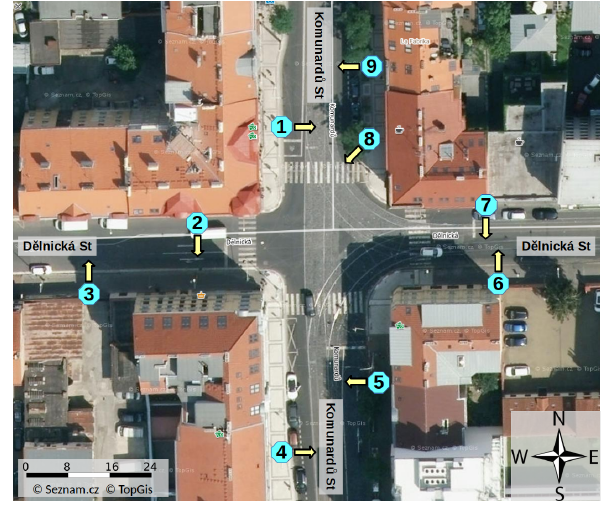
Figure 3. Observation locations. Arrows depict the orientation of the camera view. Url of the map: https://mapy.cz/s/12Qd8.